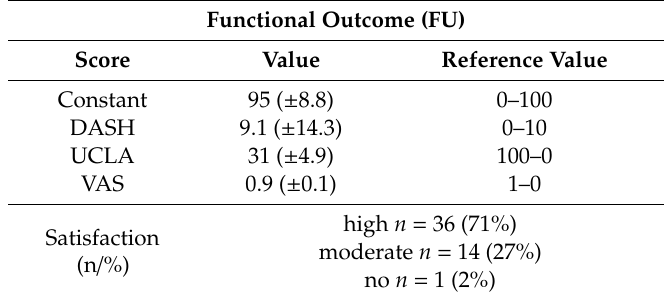
Table 2. Functional outcome (FU). The functional outcome at the time of follow up is pictured